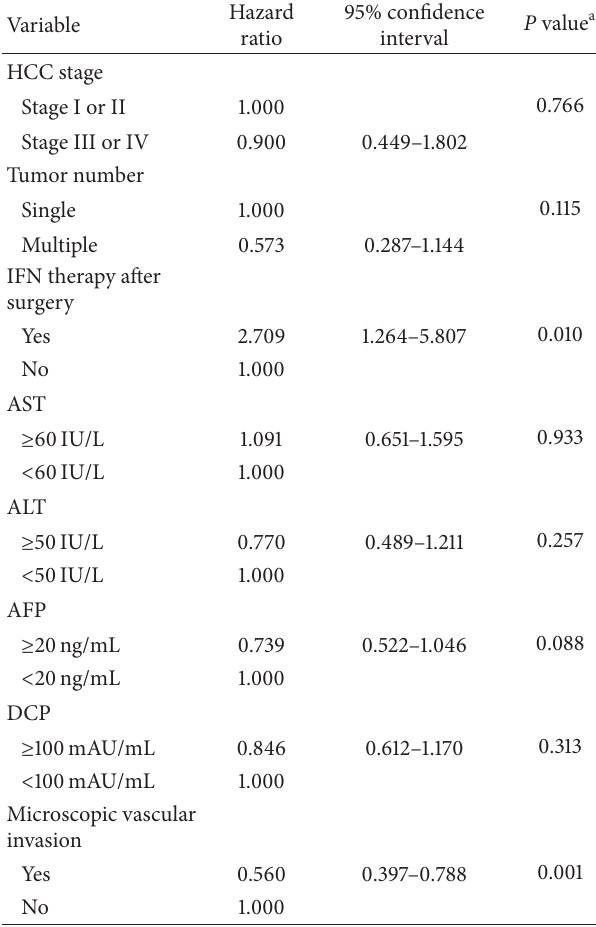
Table 4: Multivariate analysis associated with RFS after surgical resection for hepatocellular